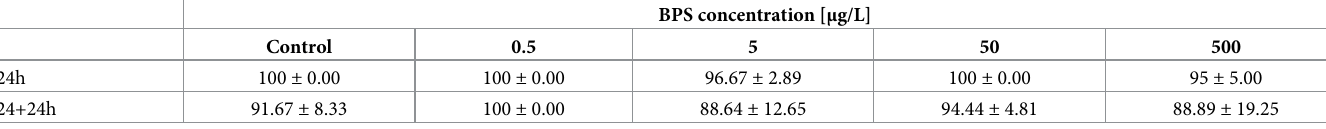
Table 2. Effect of BPS on the survival rate (%) of C . riparius larvae (n = 80) (mean ±